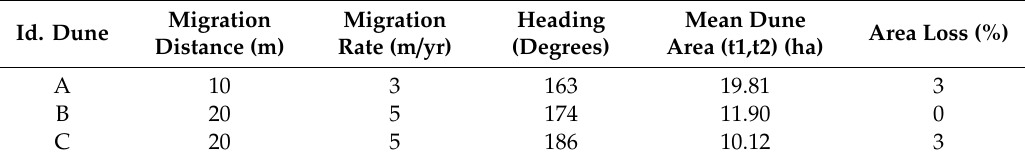
Table 6. Information extracted from [39] on the three selected dunes between 1984 and 2003 using the Landsat 5 TM located in the South Rayan dune field. Migration Migration Id. Dune Distance (m) Rate (m / yr)